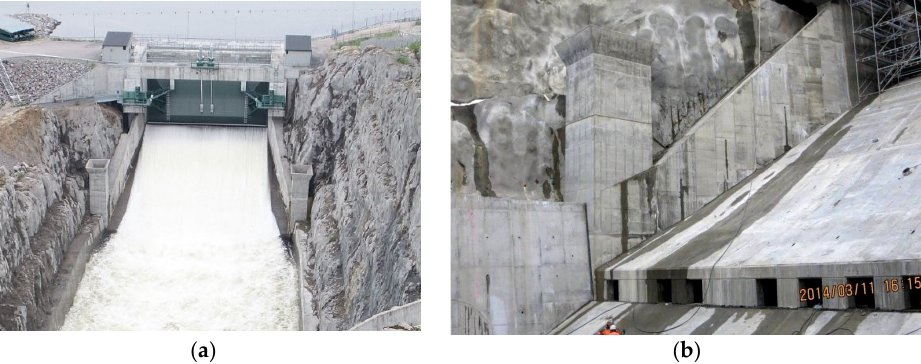
Figure 1. An aerator in a 25 m wide single ‐ opening spillway, Sweden. ( a ) spillway during discharge, looking upstream; ( b ) aerator with air shaft and air vents. At the aerator, the chute is 35 m wide between the air shafts. There are 13 air vents (each 1.0 m 2 in area) connecting the chute with the air duct (5.0 m 2 in area) leading to the shafts (each 8.7 m 2 in area). At the aerator, the unit flow discharge amounts to ~43 m 2 /s at the full reservoir water stage.